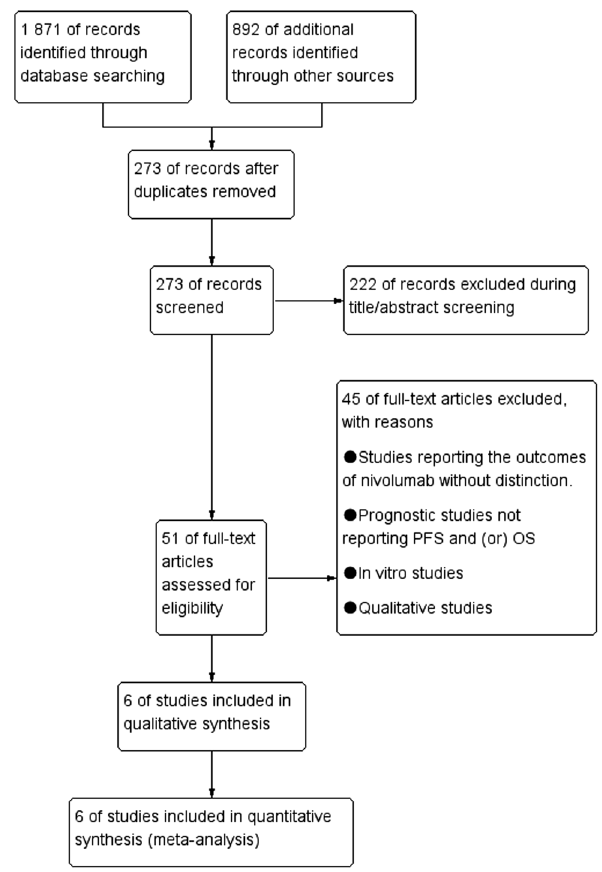
Figure 1: Flow diagram of the included